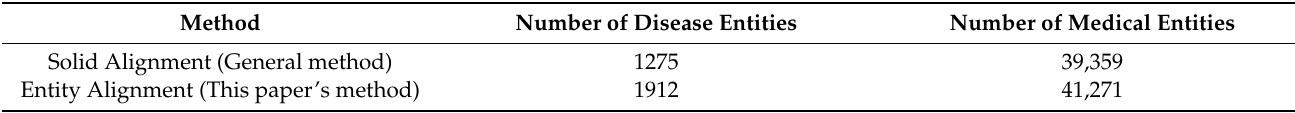
Table 4. Statistics of the results of the two entity alignment